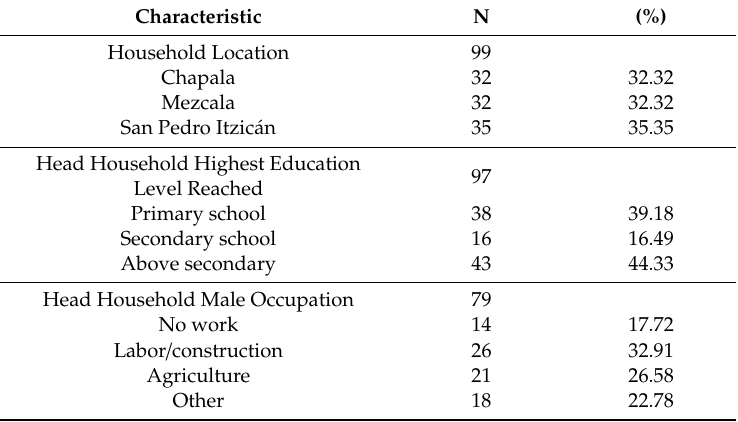
Table 2. Sociodemographic characteristics of